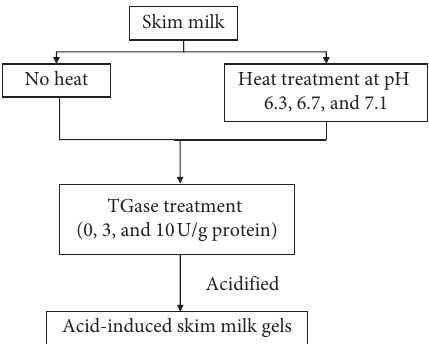
Figure 1: The experimental design of the